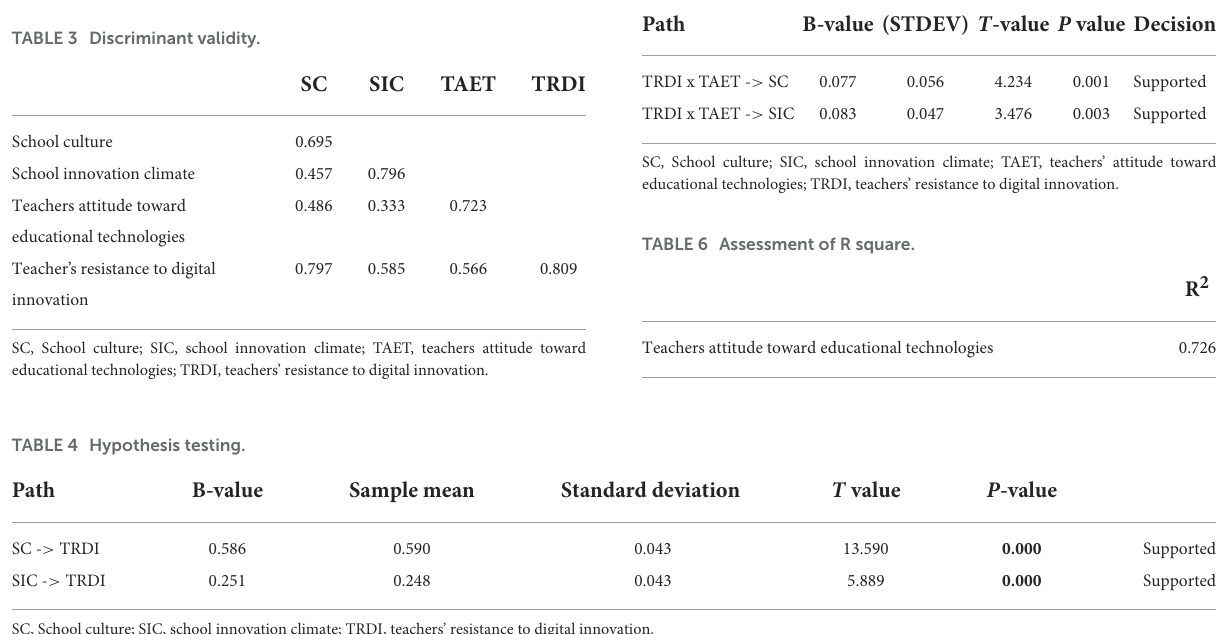
TABLE 5 Moderator hypothesis testing.